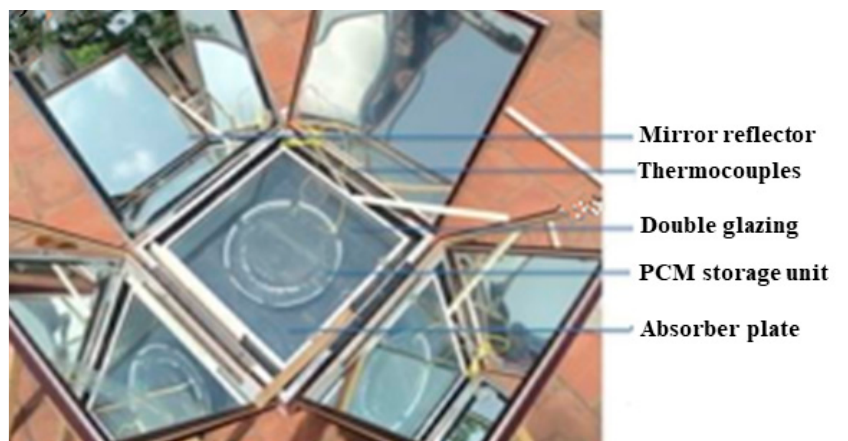
Figure 19. SBC with reflectors fabricated with PCM. Reprinted/adapted with permission from Ref. [61], 2017, AIP Publishing.